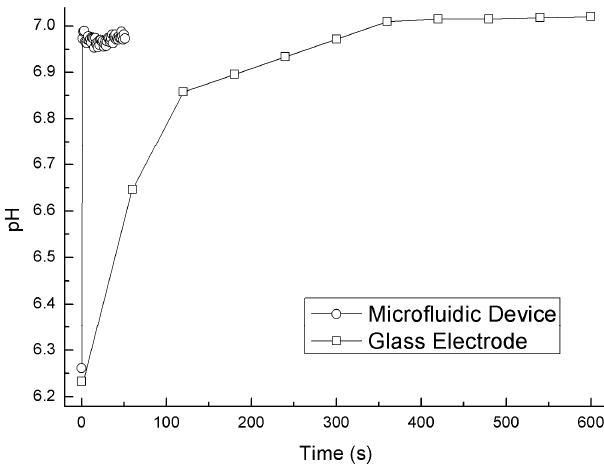
Figure 8. Response curves of the diluted solution (6.86/100) measured by the present system and a conventional glass electrode. The data at Time = 0 for the microfluidic device is plotted immediately before the solution for the microfluidic device was switched. The data at Time = 0 for the glass electrode is plotted immediately after the electrode was immersed in the solution for the electrode.